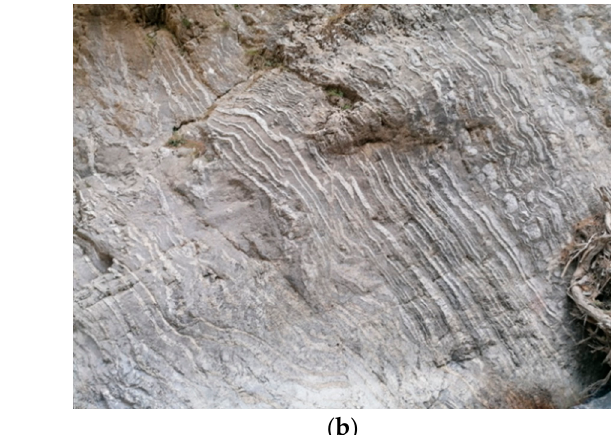
Figure 9. The main lithological formations outcropping in the Samaria Gorge: ( a ) Gigilos formation, consisting of phyllites and slates. The slopes are characterized by smooth dip angles; ( b ) Plattenkalk formation, consisting of recrystallized limestones with chert intercalations, showing steep slopes.